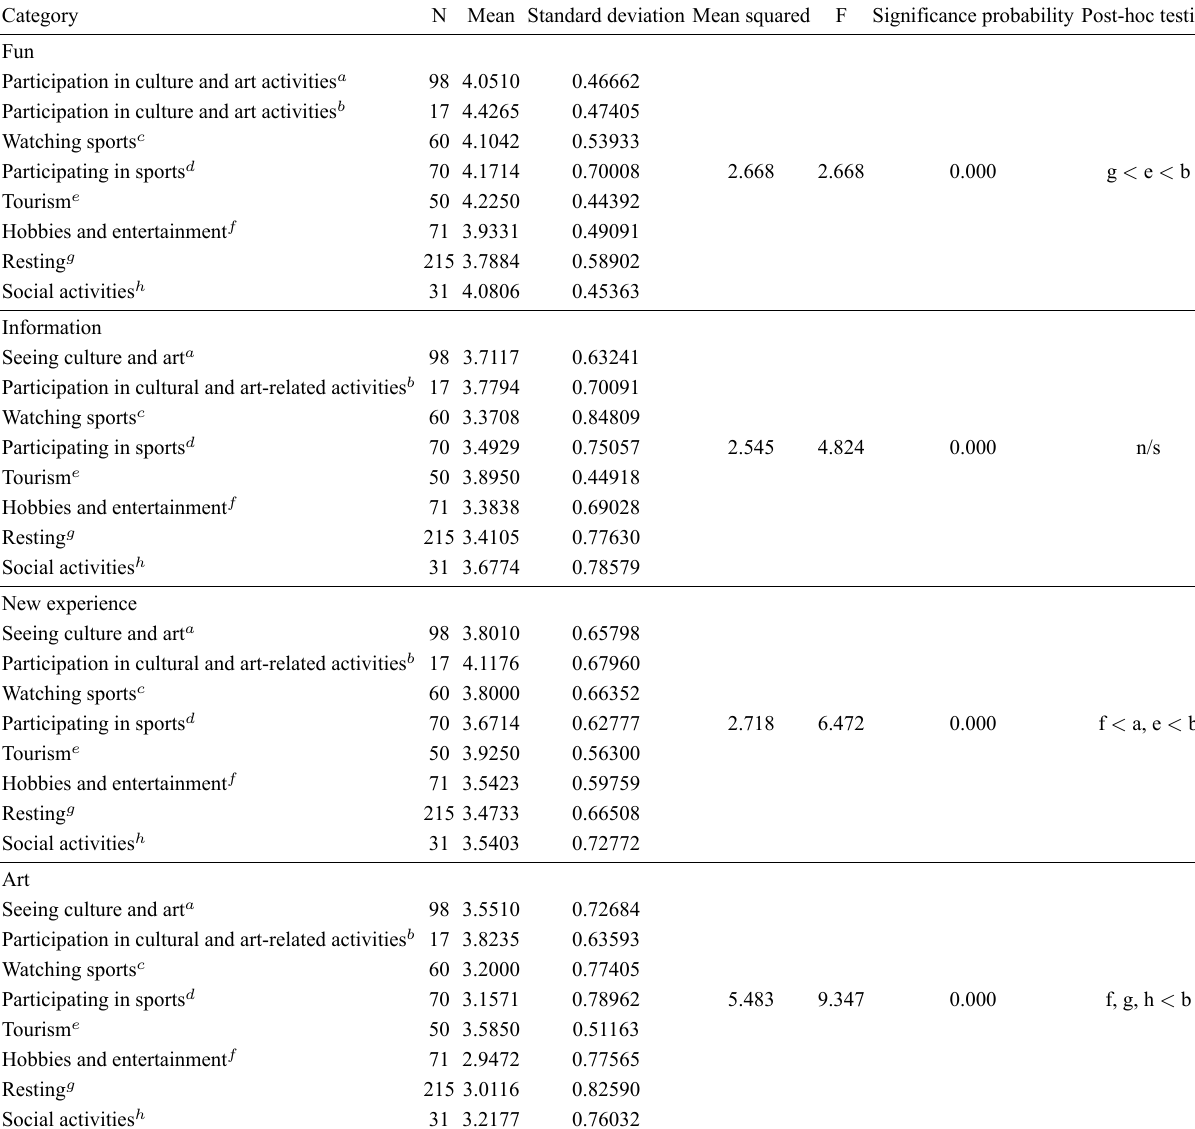
Table 5. Differences in leisure activities for the stress group (n =